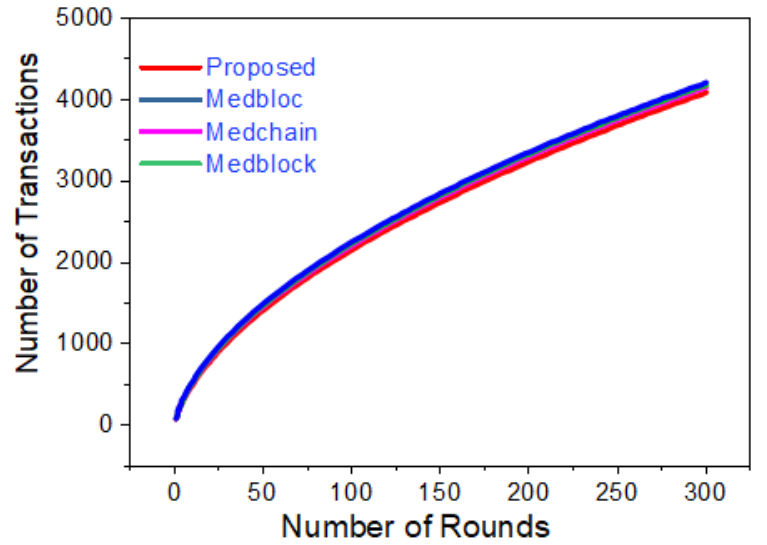
Figure 21. Comparative analysis of the proposed flexible policies for the cross-domain case and the benchmark models [49–51] (number of rounds versus number of